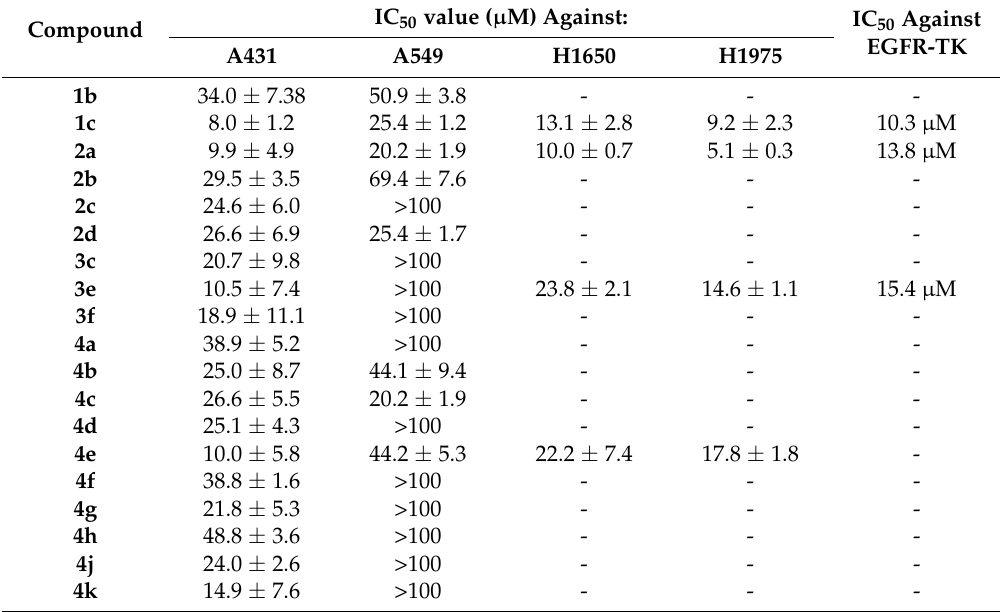
Figure 2. Relative survival rate (%) of the ( A ) A549 and ( B ) A431 cells after treatment with 100 µM of the indicated chalcone derivative or erlotinib for 72 h. Data are shown as the mean ± one standard deviation, derived from three independent repeats of triplicate cultures. Means in red bars are ≤ 50% survival (below the black dashed line) and those with a different letter are significantly different (p < 0.05). Table 1. Derived in vitro cytotoxicity IC 50 values of the potent chalcone derivatives against the A431,